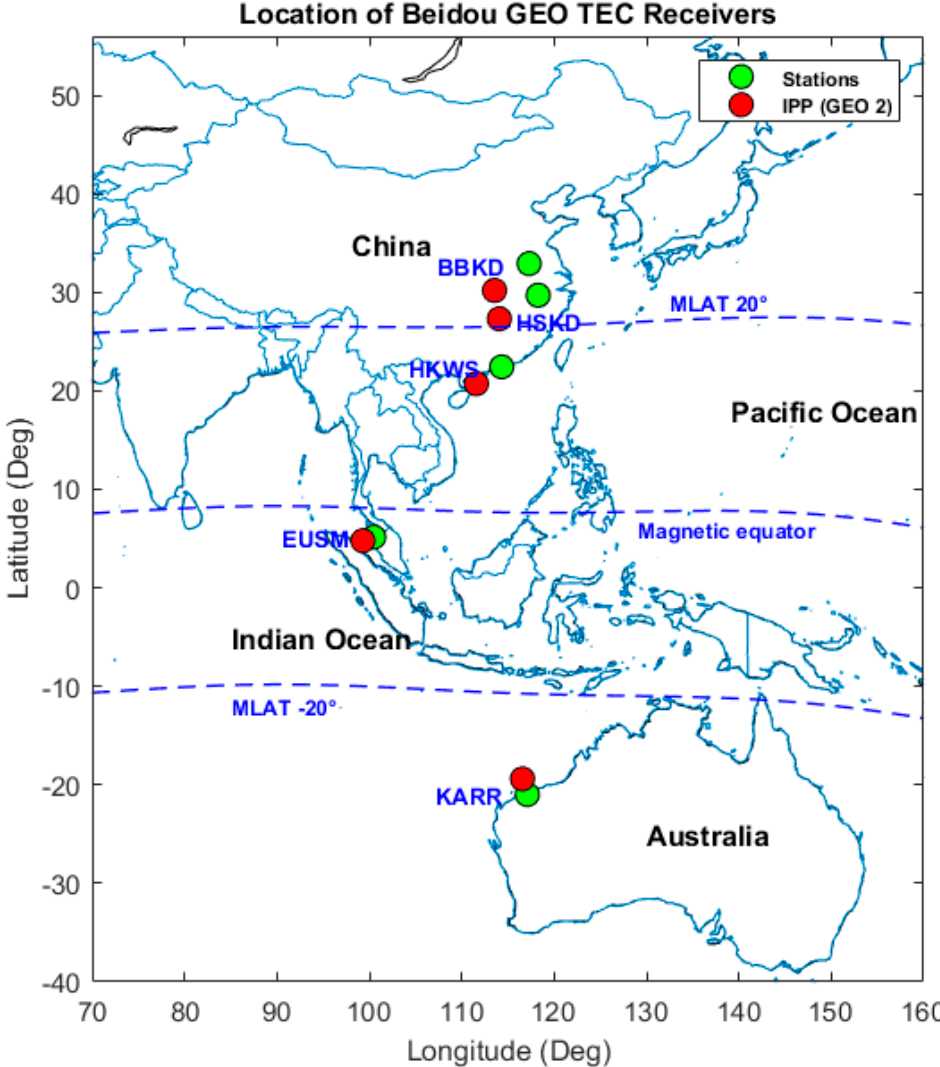
Figure 1. Location of the Global Navigation Satellite System receivers (green) and corresponding ionospheric pierce points (IPPs, red) used in the present study. The blue dash lines indicate the ± 20 magnetic latitudes and the magnetic equator.